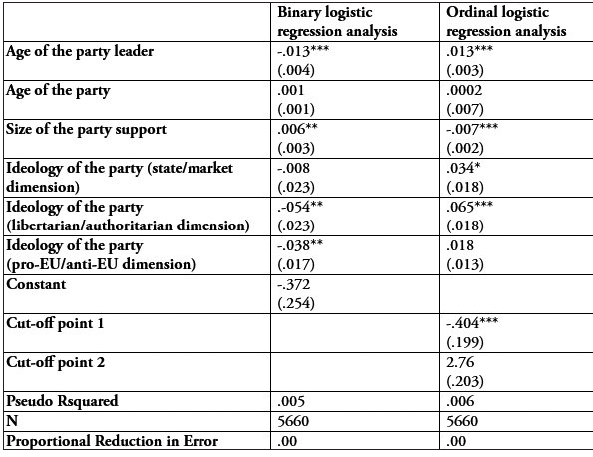
Table 7: Binary logistic and ordinal logistic regression models meas-